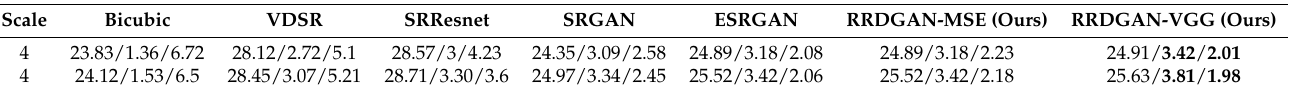
Table 1. PSNR/MOS/Perceptual Index results (low resolution with noise) of applying methods to UCMERCED, NWPU- RESISC45 and GaoFen-1.